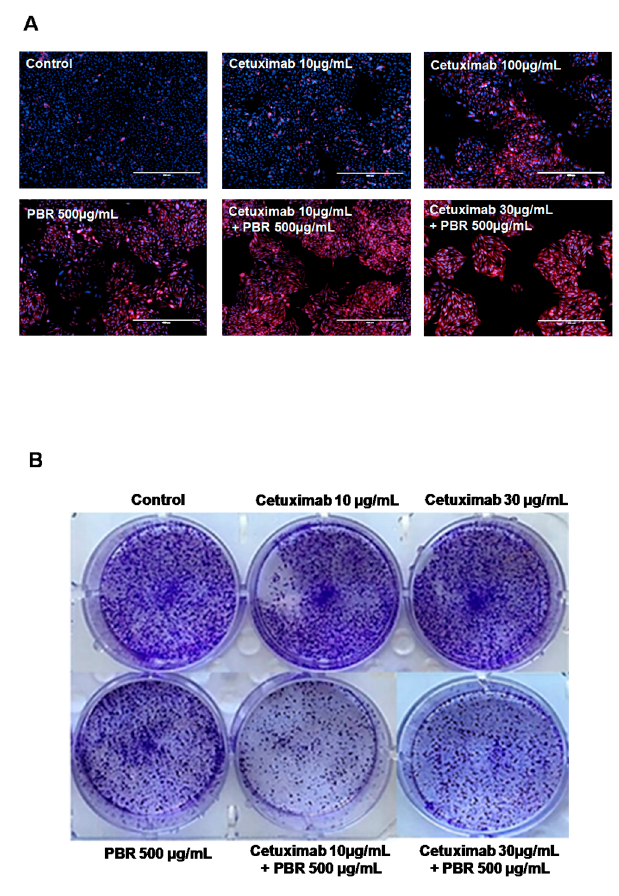
Figure 2. ( A ) Representative SW480 cell images after cetuximab (10, 100 µ g/mL), PBR extract (500 µ g/mL), or combined cetuximab and PBR extract treatment. Blue represents DAPI-stained cell nuclei, and propidium iodide-stained dead cells are red. (Scale bar = 500 µ m); ( B ) Clonogenic assay images after cetuximab (10, 30 µ g/mL), PBR extract (500 µ g/mL), or combined cetuximab and PBR extract treatment on day 10. PBR, Phellinuslinteus grown on germinated brown rice; DAPI, 4 ′ ,6-diamidino-2- phenylindole.